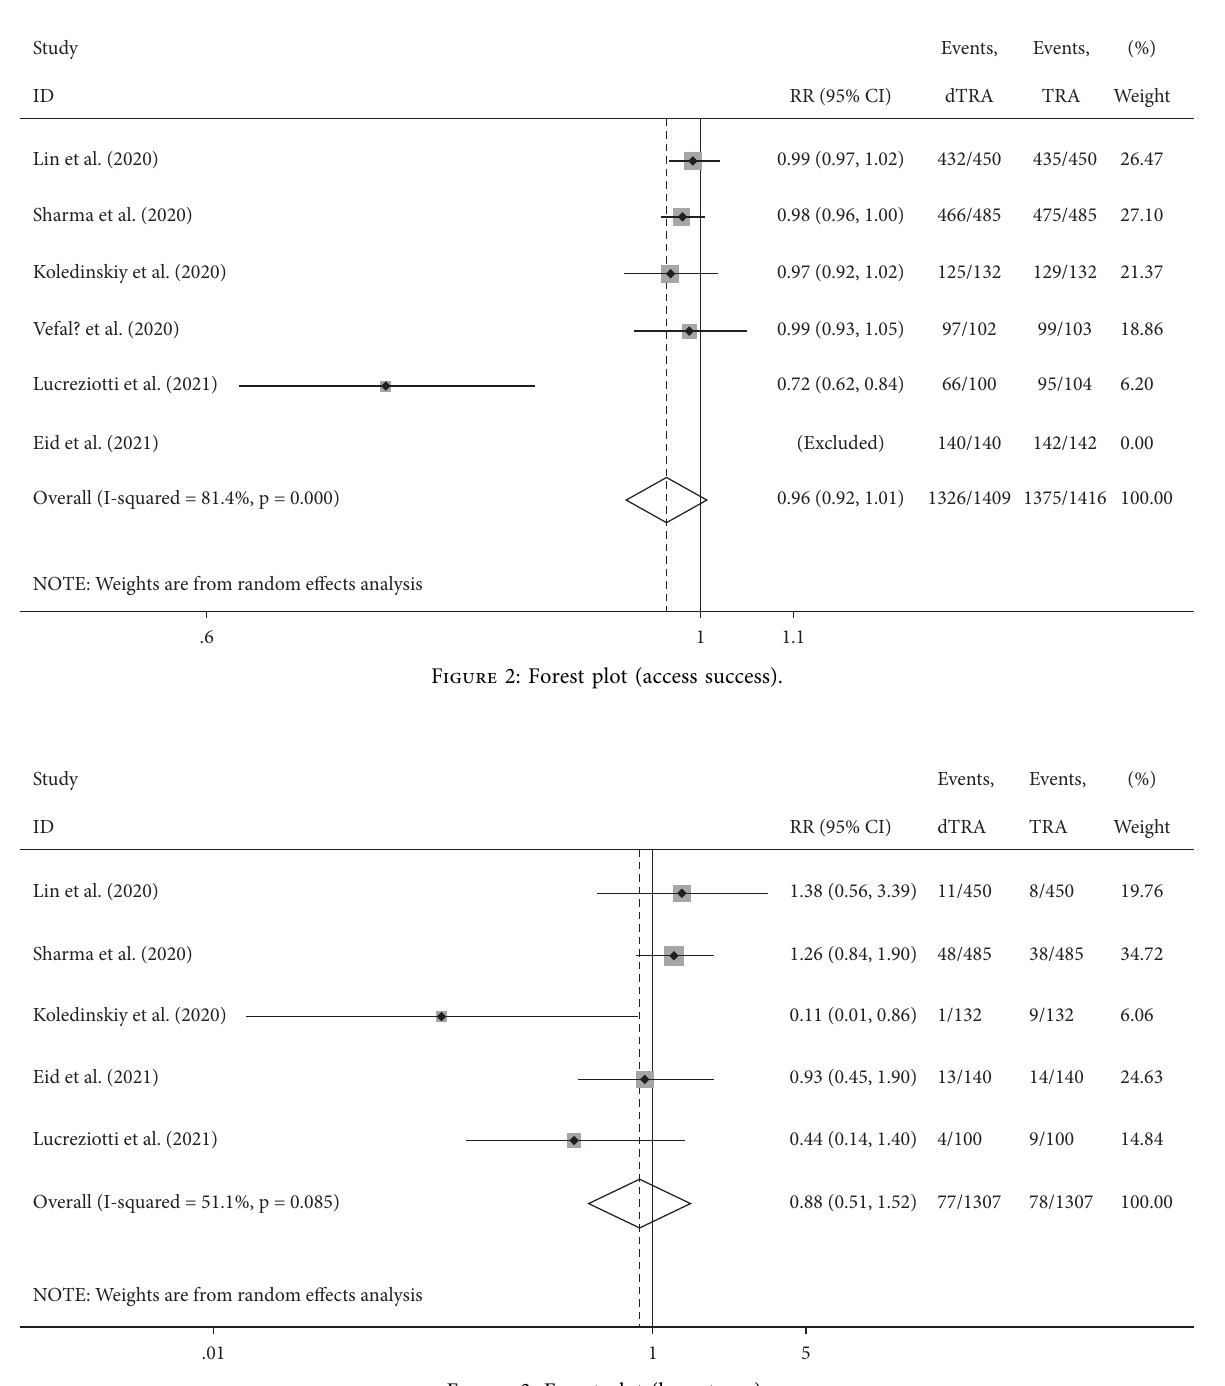
Figure 3: Forest plot (hematoma).